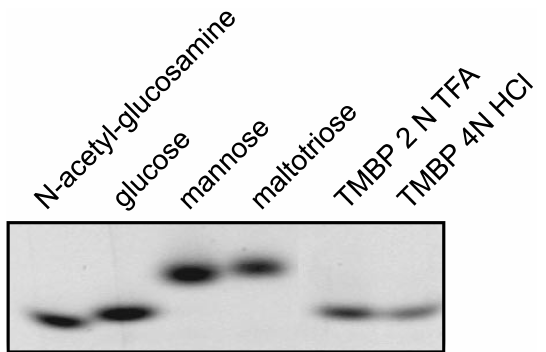
Figure 5. Purification of trehalose/maltose binding protein (TMBP): Coomassie stained gel. The TMBP was purified from Triton X-100 solubilized membranes by ConA affinity chromatography and MonoQ anion exchange chromatography.